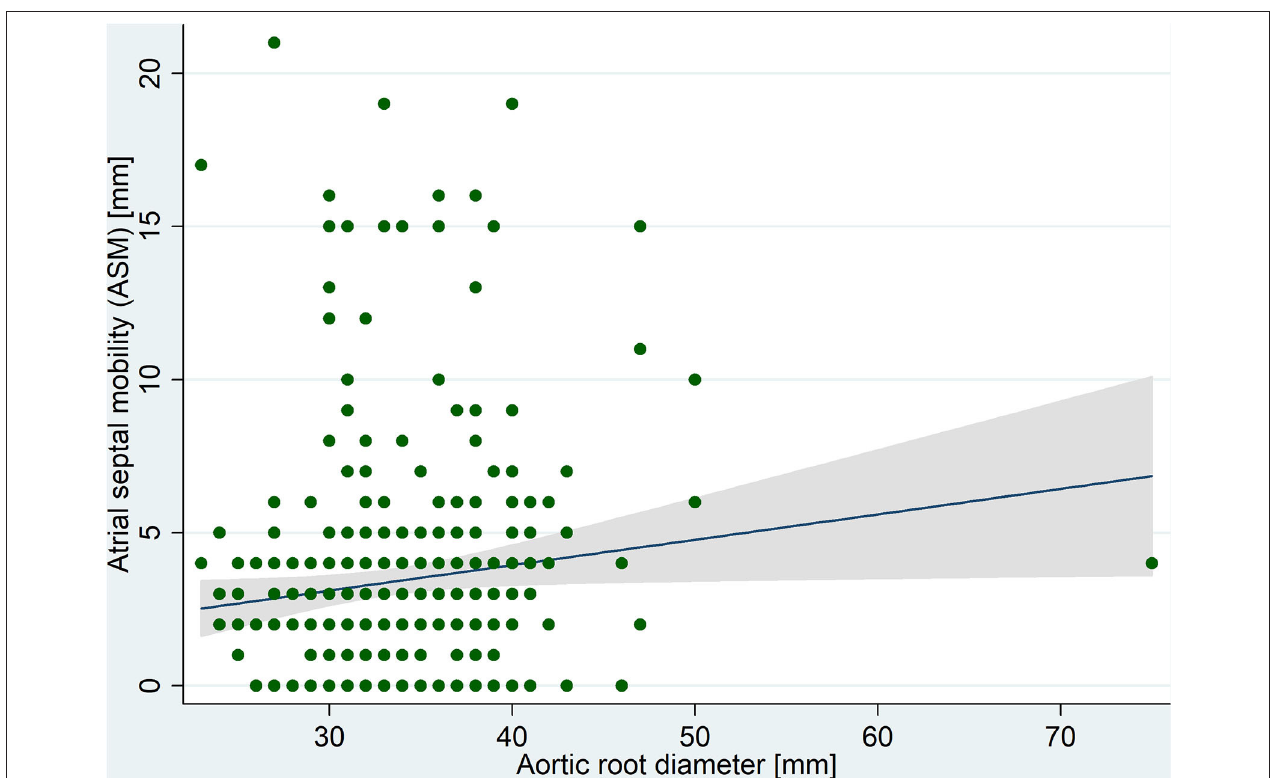
FIGURE 2 | Correlation between atrial septal mobility and aortic root diameter measured in transesophageal echocardiography images.